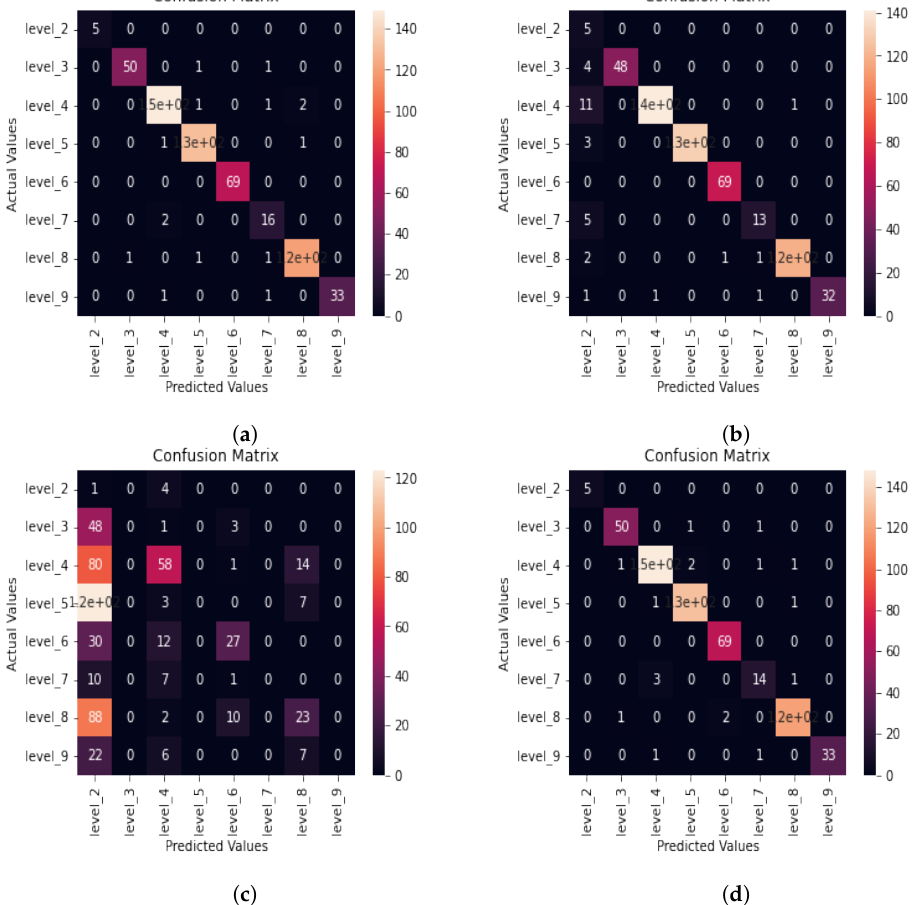
Figure 9. Confusion matrices of different machine learning models for aphasia severity level classifi- cation whose features were extracted using MFCC for 10 s long audio input. ( a ) Confusion matrix of DNN. ( b ) Confusion matrix of KNN algorithm. ( c ) Confusion matrix of decision tree algorithm. ( d ) Confusion matrix of random forest